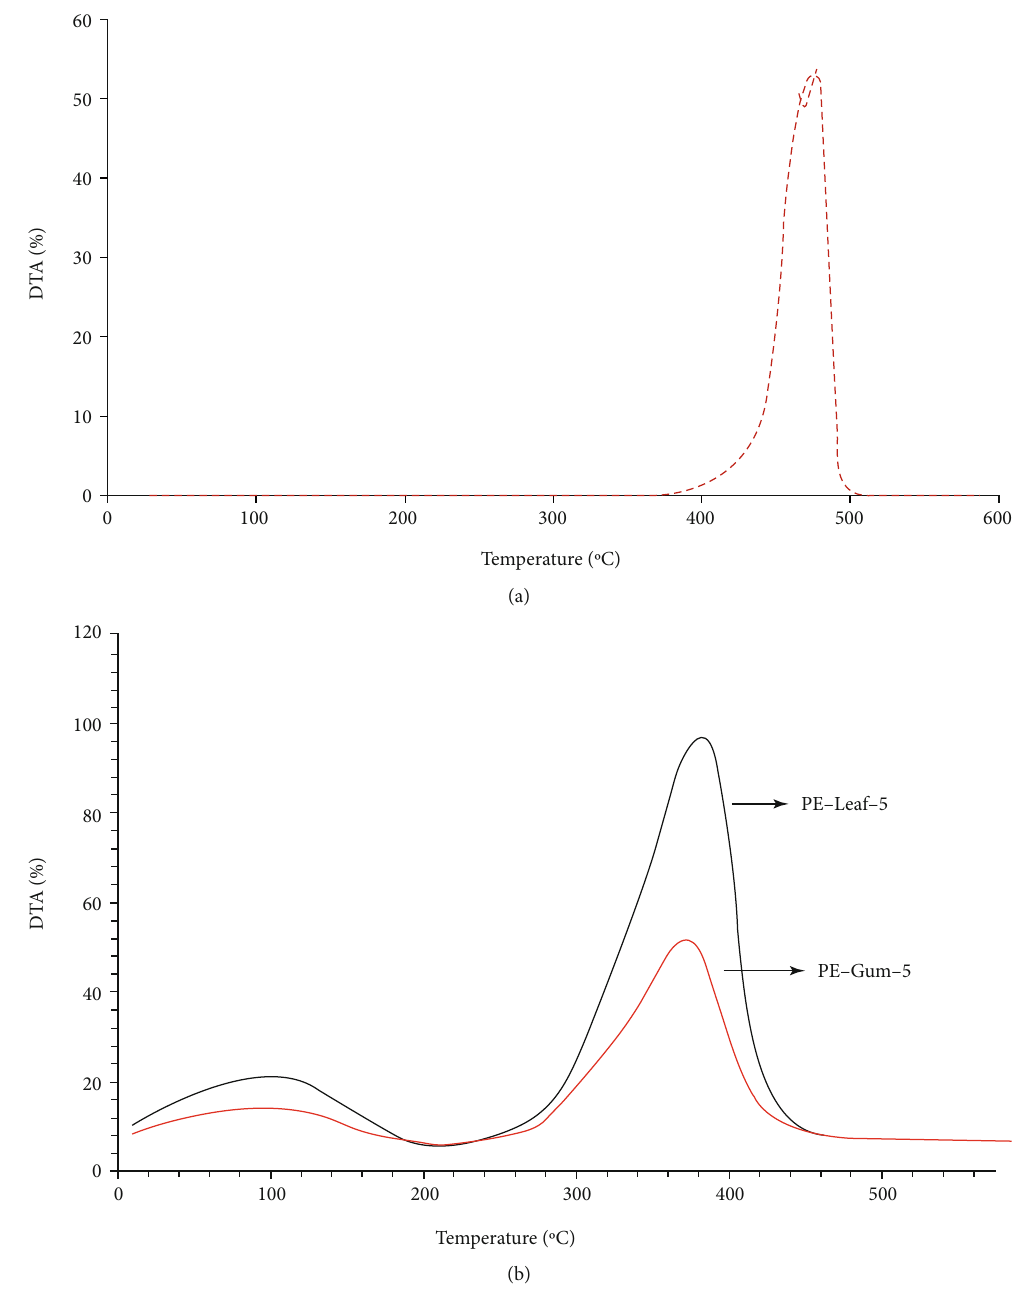
Figure 4: DTA thermograms: (a) pure LDPE fi lm; b) active fi